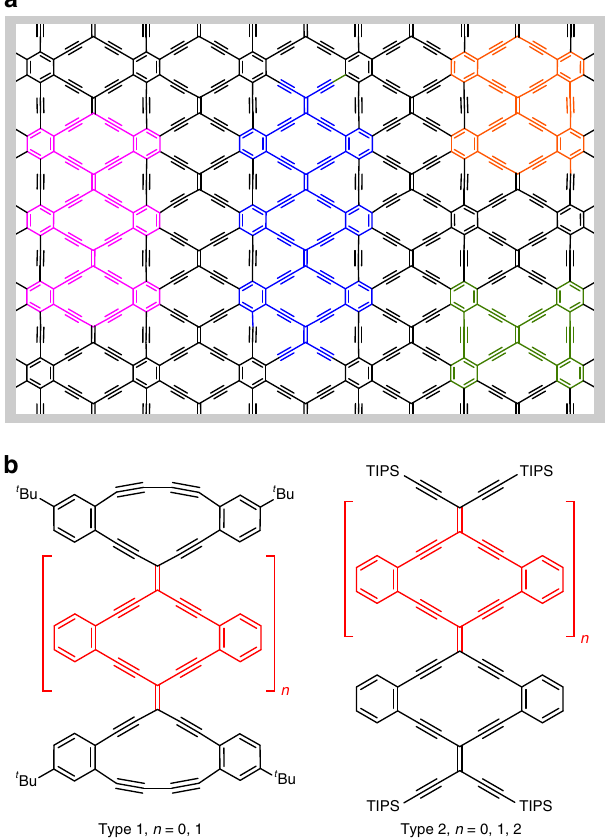
Fig. 1 Structure of 6,6,12-graphyne. a Schematic representation of 6,6,12- graphyne with fragments highlighted in colors. b Radiaannulene oligomer model systems of Type 1 and Type 2. t Bu = tert -butyl, TIPS =